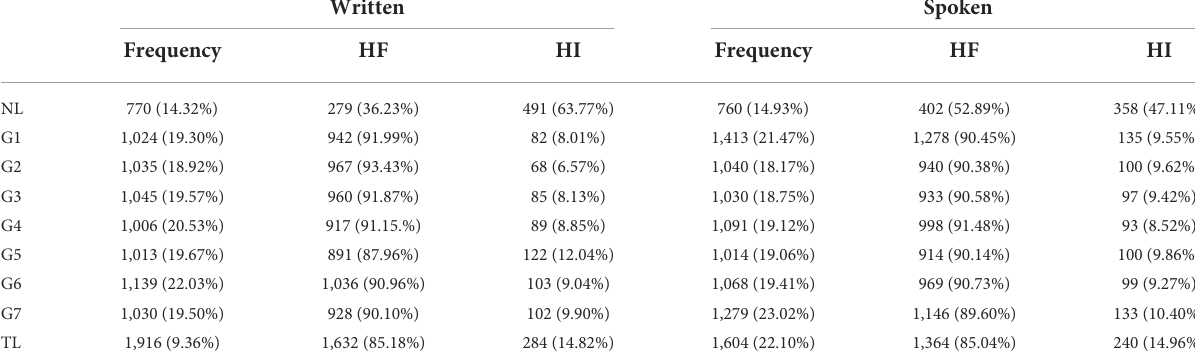
TABLE 6 Frequencies and dependency direction distributions of adverbials at each level and in contrastive treebanks.